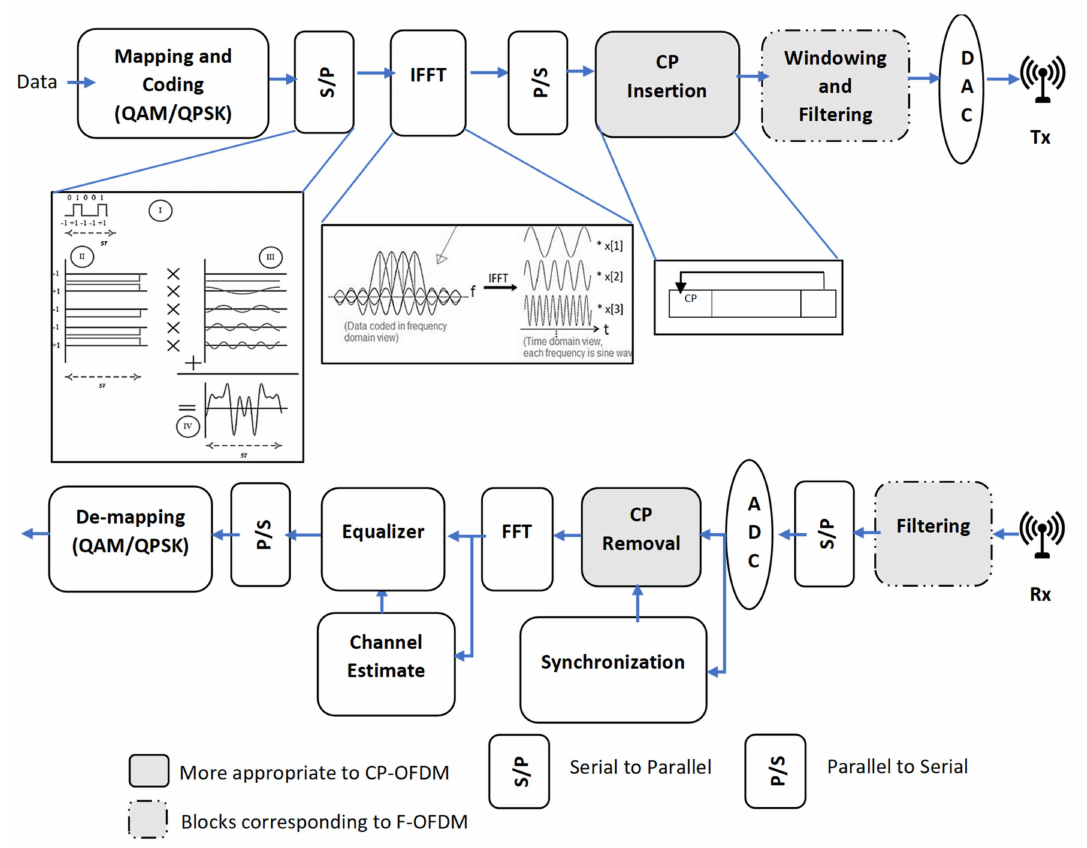
Figure 7. OFDM transceiver: firstly, the serial to parallel (S/P) converter splits the given data to several parallel streams which are converted to symbols through the mapping block. Secondly, the output of the IFFT block, after parallel to serial (P/S) conversion, is given to the next block for insertion of the CP. After the spectrum shaping process, the data are converted to analogue signals to be transmitted through the Tx antenna. In the receiver side, other filtering and S/P conversion processes are performed, and the signal is converted to digital data (symbols). Afterwards, the CP needs to be removed from the symbols, and an FFT is performed. The channel estimation is the most important block in the receiver. The given output data of this block are given to the equalizer to correct the channel effect. Finally, after P/S conversion, the symbols are de-mapped to bits. The CP insertion and removal blocs are used with cyclic prefix OFDM (CP-OFDM), which widely reduces the